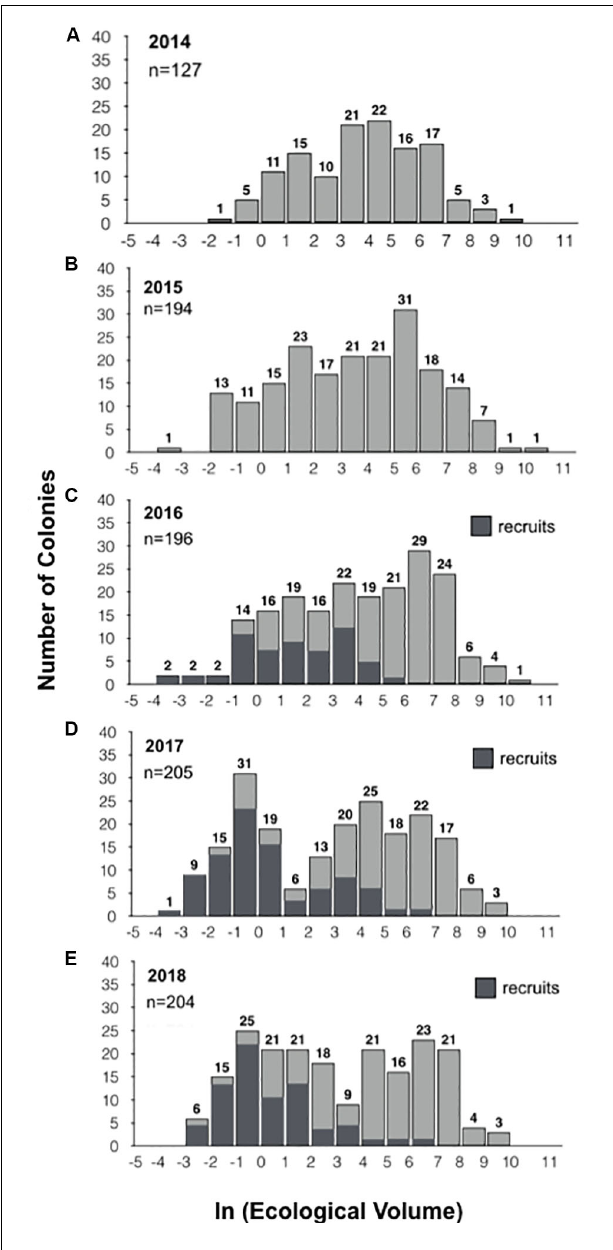
FIGURE 2 | Population size frequency distributions. The size frequency distributions for the populations in 2014, 2015, 2016, 2017, and 2018 are displayed in panels (A–E) , respectively. Colonies were binned by size based on the natural log of their ecological volume. The number of colonies is represented above each bar. New recruits identified from 2016 to 2018 are represented in dark gray (C–E) . In 2018, we inadvertently neglected to measure a single individual, so while 204 colonies were found, size is provided for 203